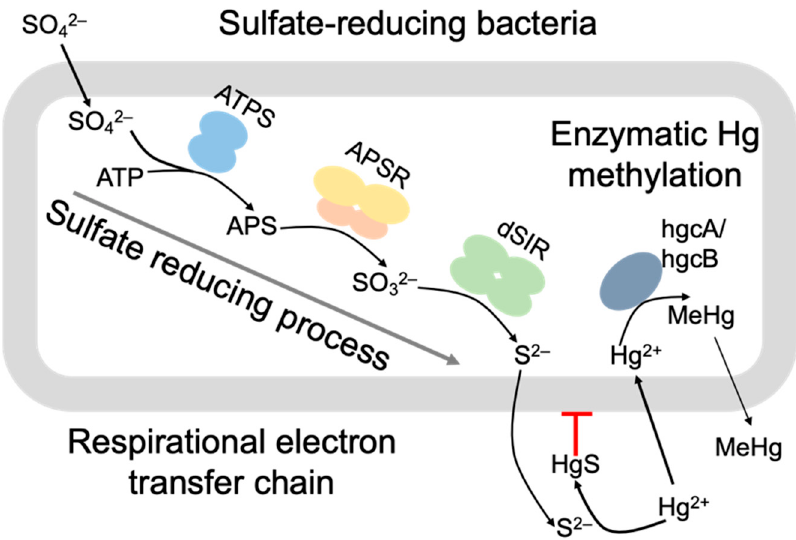
Figure 3. Sulfate-reducing bacteria could reduce sulfate ion into sulfide through a series of enzymatic processes [63,64], and could also catalyze the conversion of inorganic mercury ion into methylmercury [25,58–60,65].